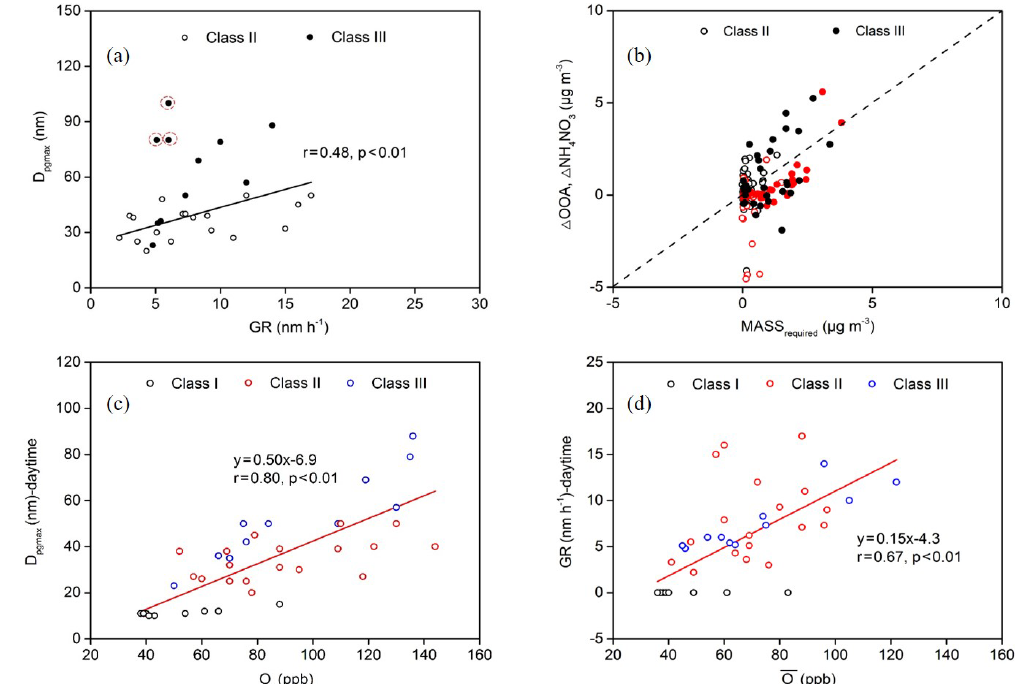
Figure 6. Relationship between D pgmax and GR (a) . Hourly variations in measured OOA (black mark) and NH 4 NO 3 (red mark, assuming NO − to be completely associated with NH + ) versus required masses of OOA and NH 4 NO 3 for corresponding particle growth (b) . Rela- 3 4 tionship between D pgmax in the daytime and the corresponding maximum O x (c) . Relationship between GRs in the daytime and the average mixing ratio of O x (d)